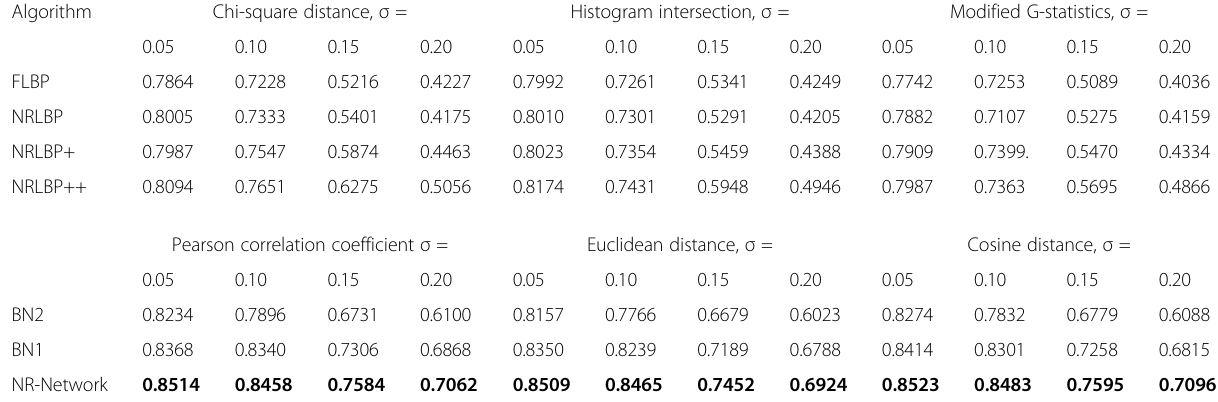
Table 3 The average recognition rates of different methods on the AR database injected with Gaussian noise Algorithm